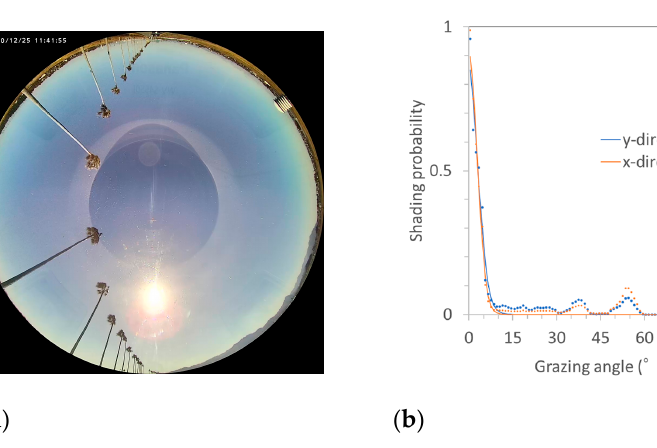
Figure 7. Calculation of the 3D shading and aperture matrix from the fi sheye image: ( a ) fi sheye image; ( b ) 2D histogram of the shading probability calculated by binarization of the image; ( c ) structure of the aperture matrix obtained by the 2D histogram of the shading probability; the shading matrix is calculated by 1– E .